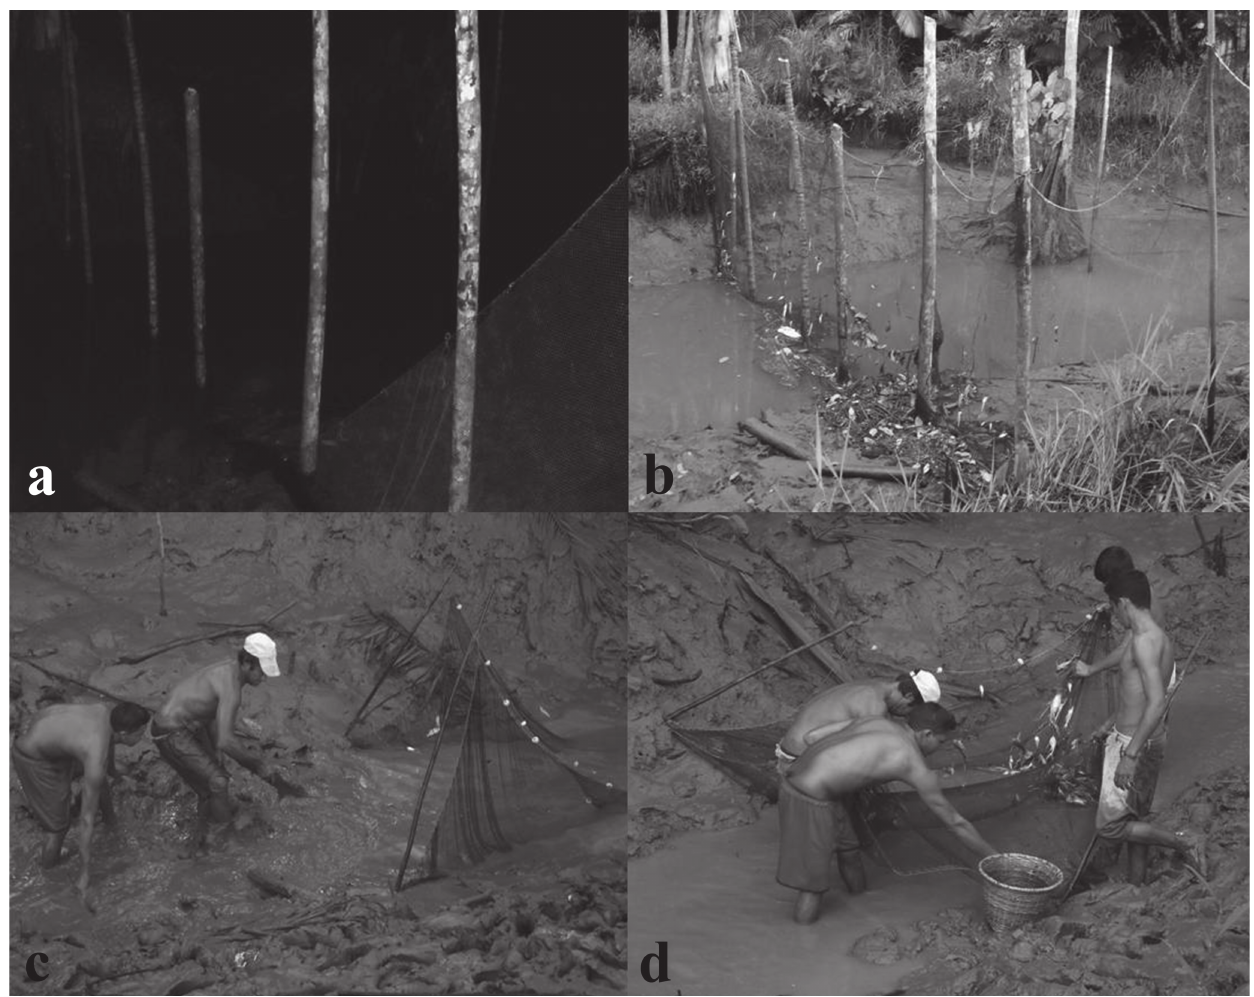
Fig. 2. Sampling method applied to capture Lithodoras dorsalis at the Amazon River mouth, Brazil, from July 2010 to June 2011. a. Net set at the bottom during the dusk and with low tide to allow the fish entrance in small rivers; b. Net lifted during the next morning (approximately, 12 hours after setting at the bottom), blocking the exit of fishes that came during the night; c and d. Fish sample using seine nets and hand- or